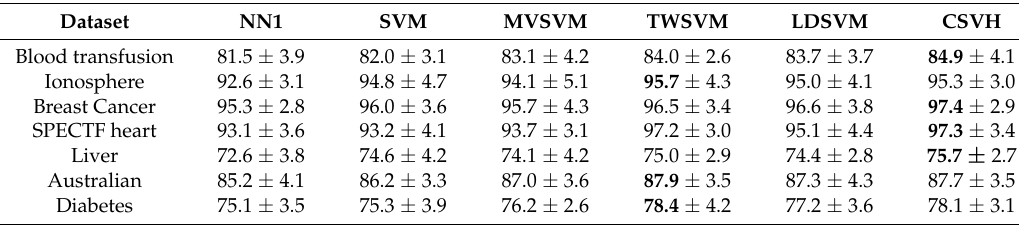
Table 2. Comparison of accuracy (%).